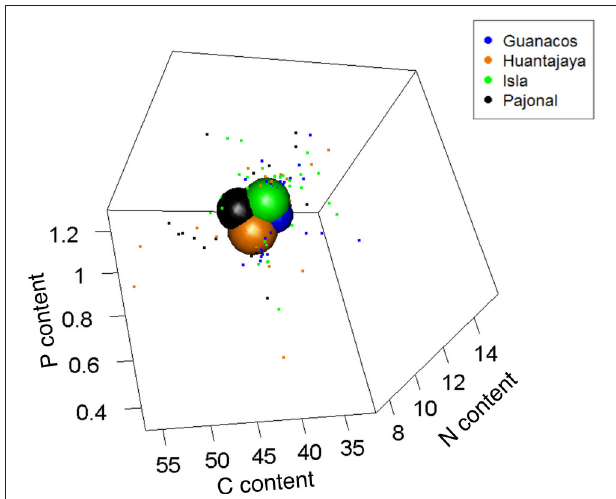
FIGURE 9 | Relative size of stoichiometric niche volumes of four geographically distinct populations of a predatory species (Arachnida, Solifugae, Ammotrechidae sp.). Sphere sizes depicts the volumes of the four populations, and are centered around the average C, N, and P contents of all individuals from those populations. Dots are individual coordinates and show the variability within a given population. Populations are labeled according to the sites where they were collected (Guanacos, Huantajaya, Isla, and Pajonal). Axes represent each element as a percentage of dry body